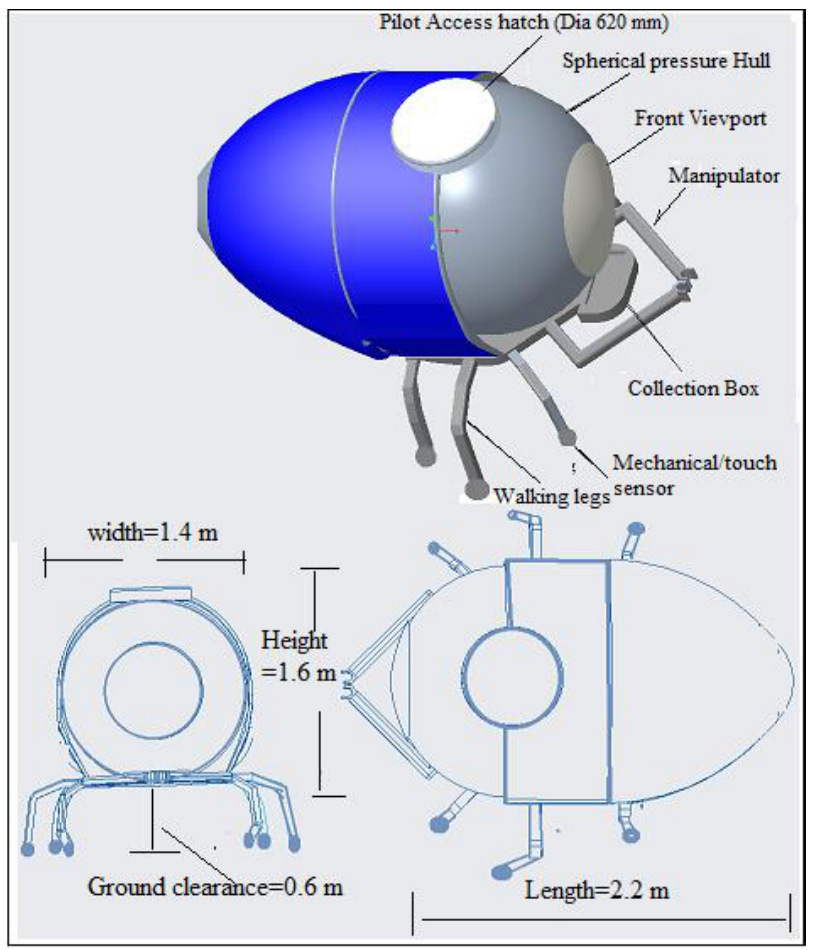
Figure 2. Conceptual design of UMSWR.